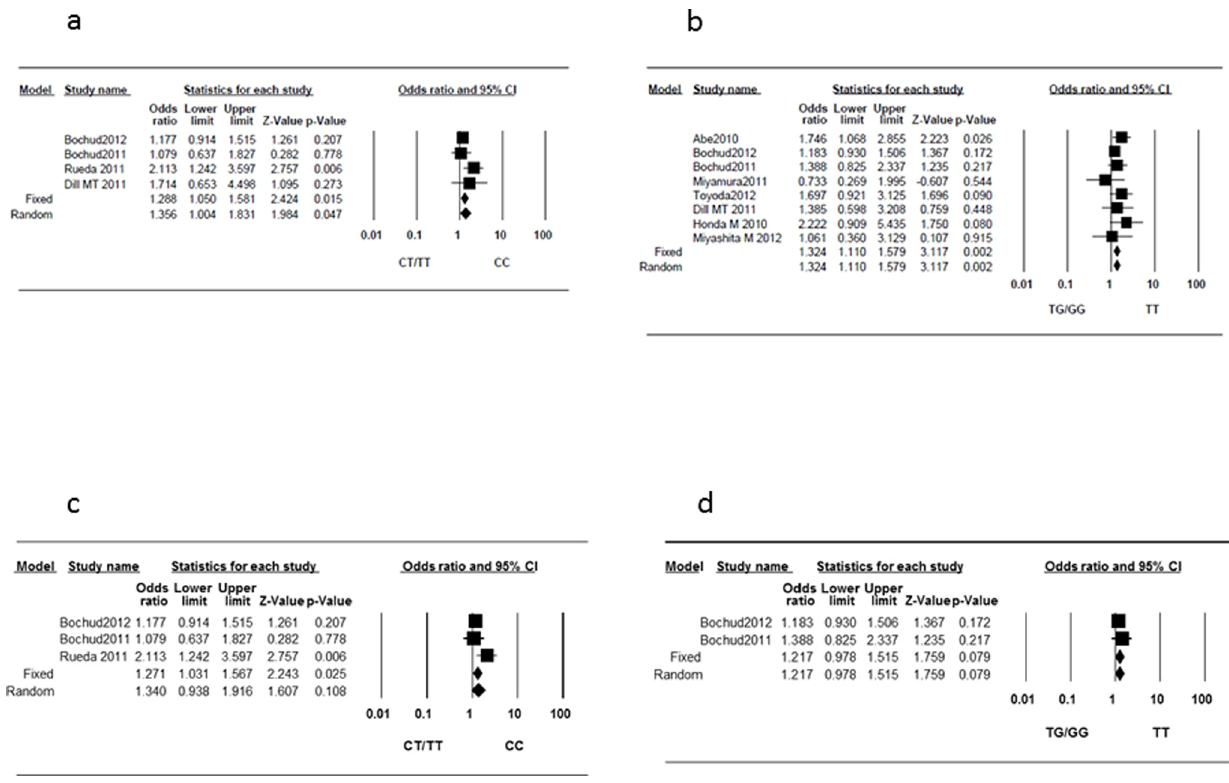
Figure 3. Forest plot of the IL28B genotypes and the risk of severe inflammation activity. (a) rs12979860 and (b) rs8099917. (c) rs12979860 in treatment-naı¨ve patients, and (d) rs8099917 in treatment-naı¨ve patients.